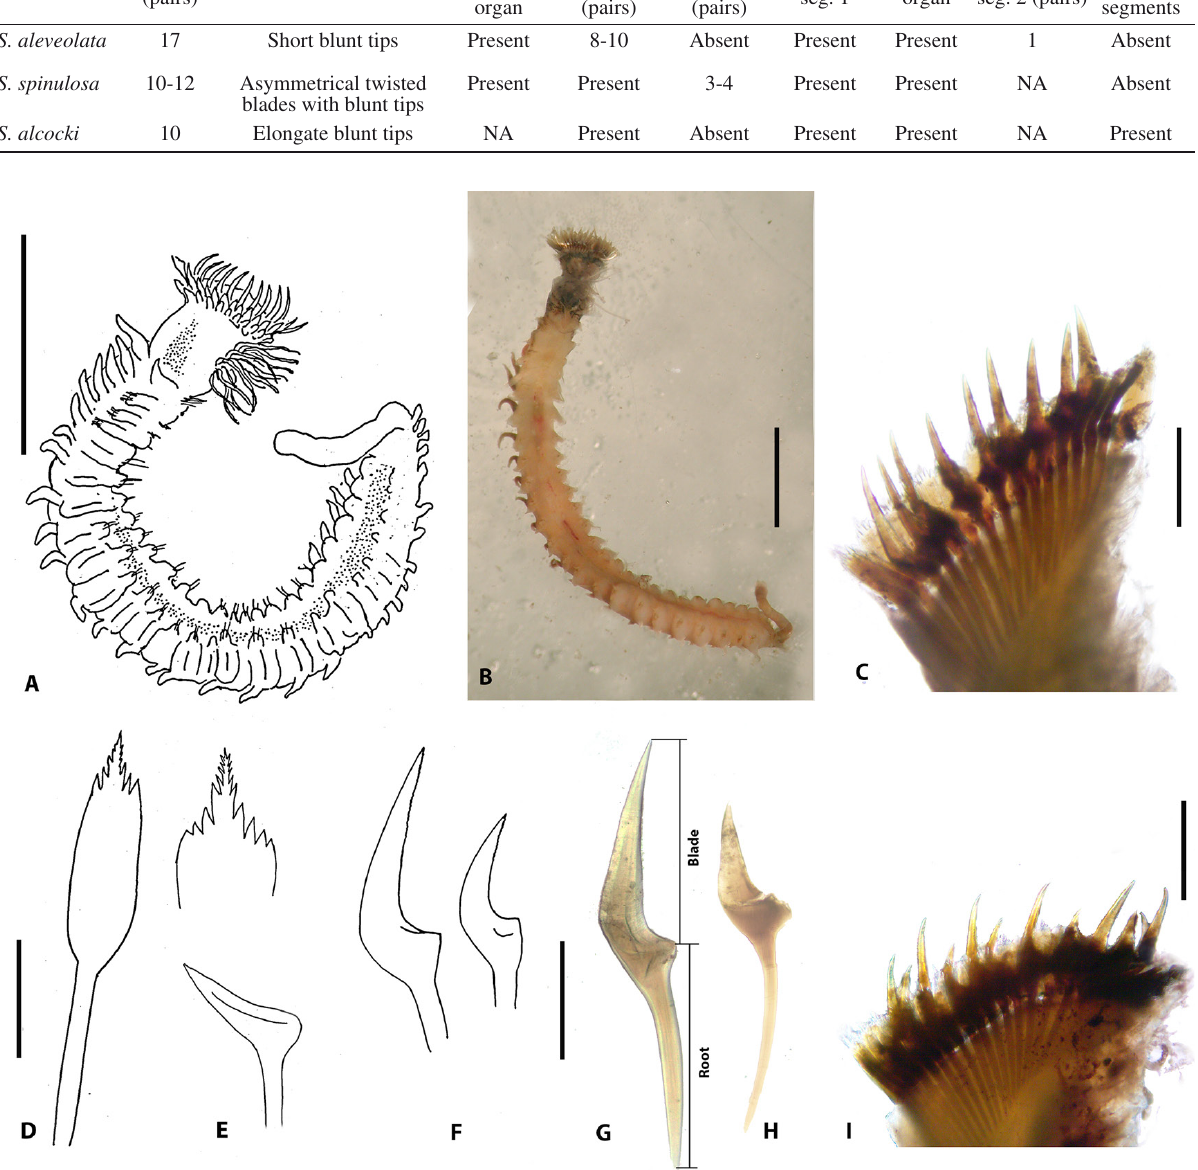
Fig. 2 . – Sabellaria spinulosa . A-B, entire worm (scale bar 0.5 cm); C, detail of the operculum of a specimen showing the homogeneous development in the blade of the middle paleae (scale bar 800 μm); D, outer palea, with a detail of the denticulate plume (scale bar 300 μm); E) inner paleae; F-H, middle paleae from different specimens (scale bar 300 μm); I, detail of the operculum of a specimen with a different development of the blade (alternate long and short) in the middle palea row (scale bar 800